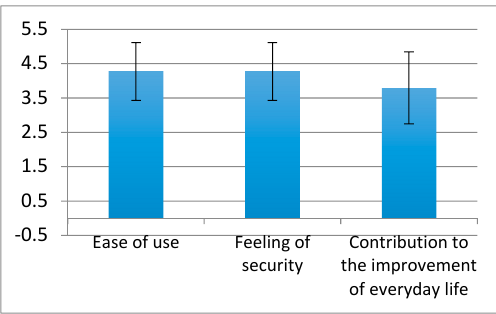
Figure 5. MOBOT’s most important features.